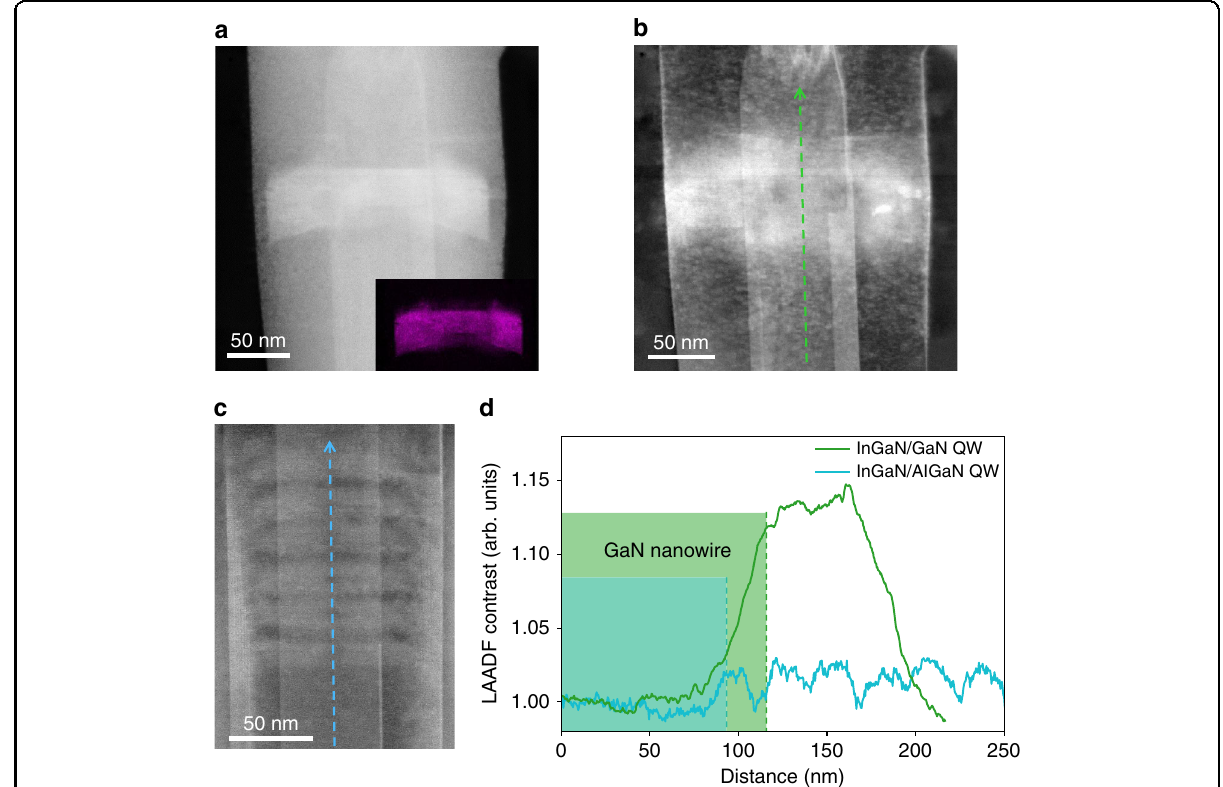
Fig. 4 Strain mapping of InGaN/(Al)GaN MQWs-in-nanowire heterostructure. a HAADF image of the active region of Sample C. Inset, EDS map showing indium distribution in the active region of Sample C. b Corresponding LAADF image of a . c LAADF image of the active region and underlying GaN of Sample A. d LAADF line pro fi le along the green dashed line in b and blue dashed line in c . The green (blue) shaded region indicates the GaN nanowire region in Sample C (Sample